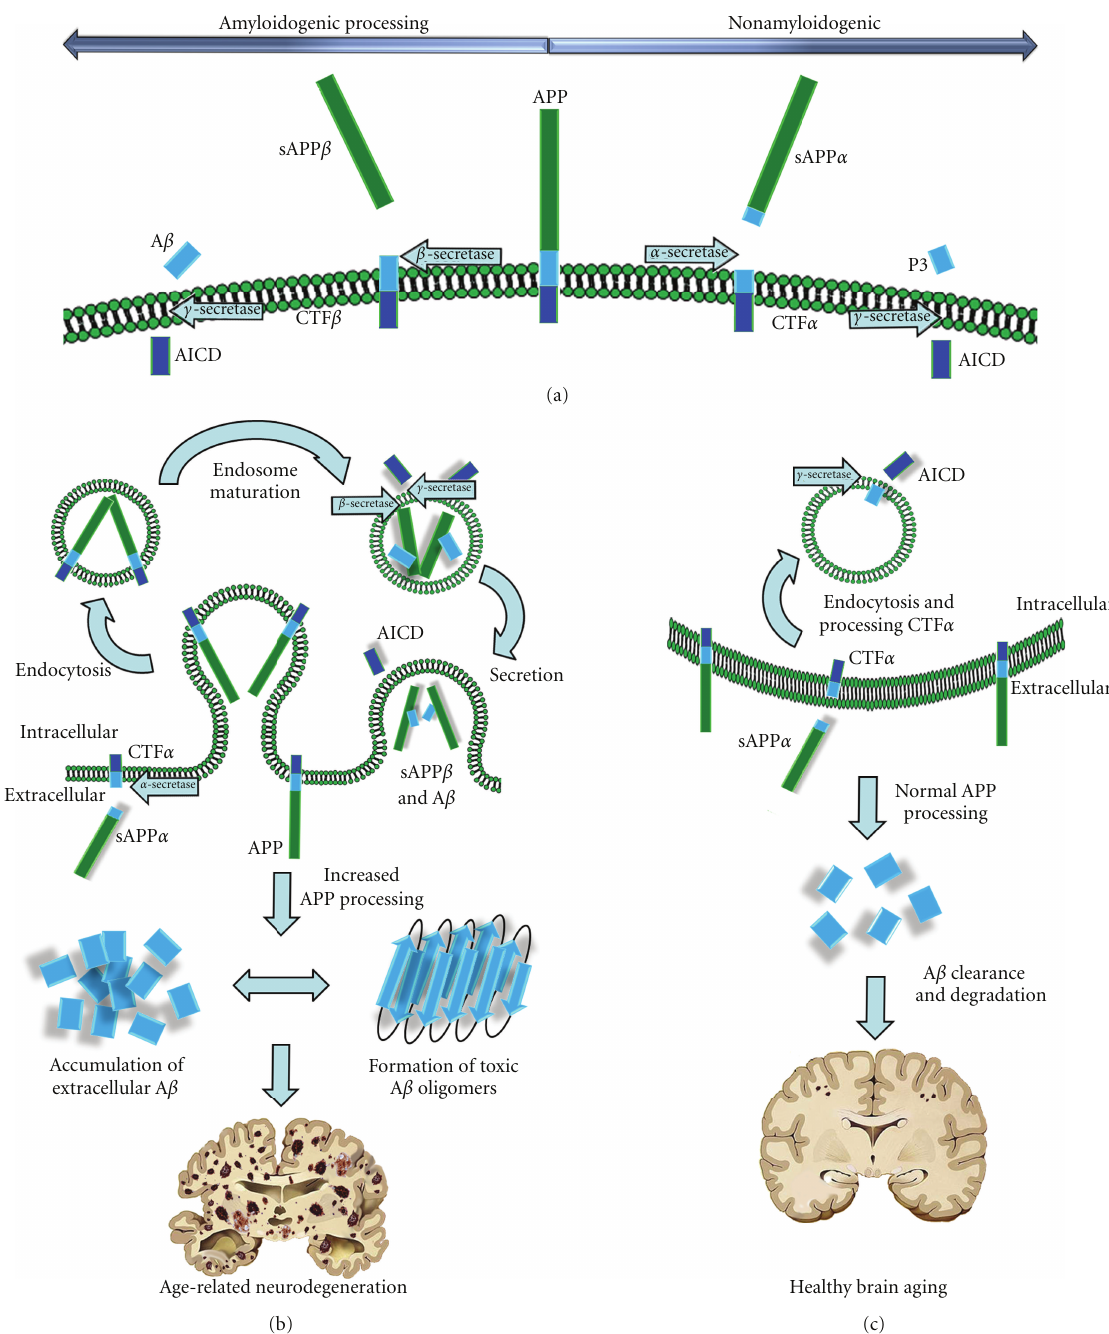
Figure 2: APP processing and imbalance in age-related neurodegeneration. (a) The amyloid precursor protein is processed either by an amy- loidogenic pathway (left) or a canonical pathway (right). Canonical processing by α -secretase results in secretion of a large extracellular frag- ment, sAPP α . Importantly, this cleavage occurs within the A β peptide fragment (light blue), preventing its formation. A membrane bound C- terminal fragment, CTF α , then becomes a substrate for γ -secretase. This cleavage occurs within the membrane, releasing a short extracellular p3 peptide, and the APP intracellular domain (AICD, dark blue). Amyloidogenic processing occurs as APP interacts with β -secretase, or BACE, in the endocytic pathway. This generates the secreted sAPP β , and a longer C-terminal fragment, CTF β ; γ -secretase cleavage of this fragment generates A β and AICD. (b) In Down syndrome, the overexpression of APP on the cellular surface results in increased amounts of APP being endocytosed. In mature endosomes, BACE (an enzyme that is more active at acidic pH) then cleaves APP resulting in increased amounts of CTF β and A β peptide (light blue) being secreted outside the cell. Increased extracellular accumulation of toxic A β species, par- ticularly A β 42 , results in the formation of A β oligomers. These oligomers then overwhelm the brains capacity for clearance and degradation and form extracellular plaques, ultimately leading to neurodegeneration and severe brain atrophy. (c) Normally, most APP is cleaved by the α -secretase, secreting sAPP α . CTF α is endocytosed and then processed by γ -secretase, resulting in formation of the p3 peptide, which is secreted, and releasing the AICD into the cytosol. BACE processing of APP does occur to generate A β (blue), but these are degraded and cleared. While few small plaques may accumulate with aging, they are much smaller and fewer in number than those associated with